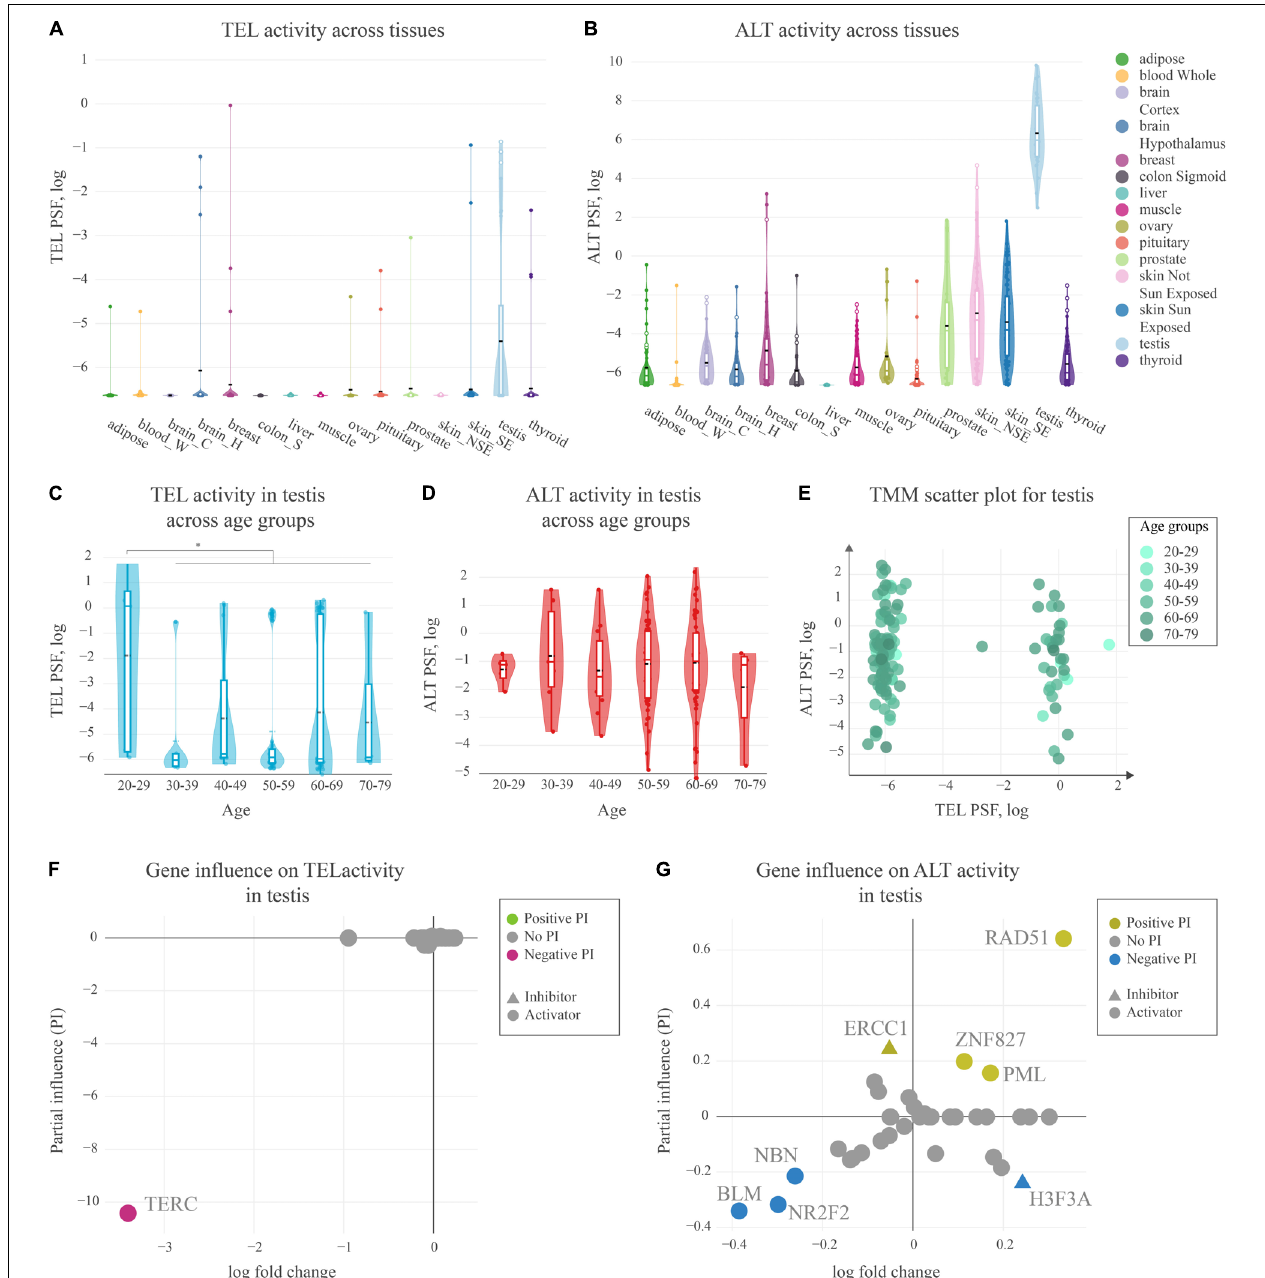
FIGURE 5 | Activity of telomere maintenance mechanisms in healthy human tissues. (A) TEL pathway activity in healthy human tissues. The black dashed lines represent means, the colored lines represent medians. (B) ALT pathway activity in human tissues. (C) TEL pathway activity in testis across age groups. (D) ALT pathway activity in testis across age groups. (E) ALT and TEL pathway activity scatter-plot in testis colored by age-groups. (F) Partial influence (PI) of TEL pathway genes on the pathway activity. (G) PI of ALT pathway genes on the pathway